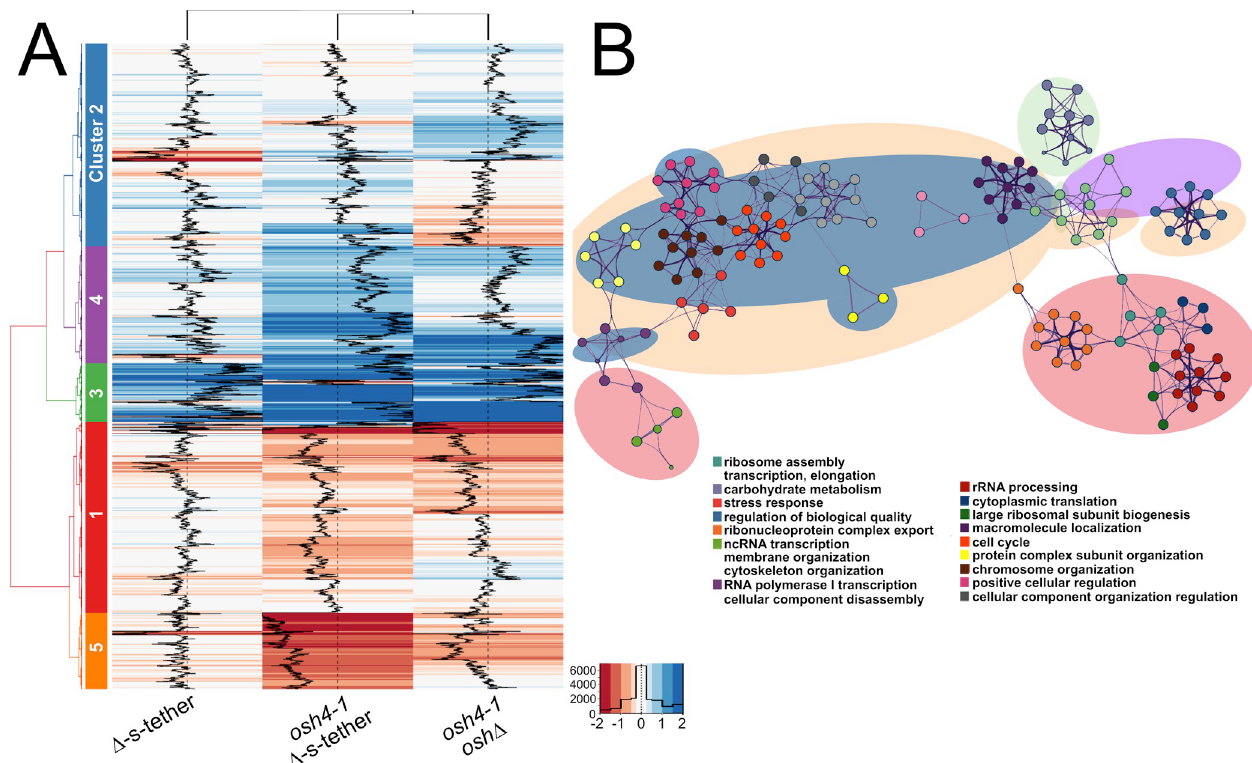
Fig 7. Hierarchical clustering of transcriptomic responses in osh4-1 ts osh Δ , Δ -s-tether, and osh4-1 ts Δ -s-tether cells. (A) Hierarchical clustering analysis of genomic transcriptional changes corresponding to osh4-1 ts Δ -s-tether (CBY6031) and osh4-1 ts osh Δ (CBY926) cells relative to WT (SEY6210) at 37˚C for 1 h, and Δ -s-tether (CBY5898) relative to WT cultured at 30˚C. Based on differential gene expression, genomic responses were separated into five distinct clusters, as denoted by the colours and numbers adjacent to the heatmaps and analyzed using Metaspace. (B) Clustered Gene Ontology (GO) analysis of gene functions corresponding to each of the five gene clusters. As specified by colour and described in the figure key, each node represents a distinct enrichment of gene sets that reflect a separate GO term. Clusters of nodes are grouped as corresponds to the clusters as shown in (A).